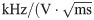
Linear rate response functions and quantities for the cascade models.Linear rate response functions of EIF neurons subject to white noise input for modulations of the input mean around μ with constant σ: Rμ(t; μ, σ) in kHz/V (A, gray) and for modulations of the input standard deviation around σ with constant μ: Rσ(t; μ, σ) in kHz/(V·ms) (B, gray). These functions are calculated in the Fourier domain for a range of modulation frequencies [R^μ(f;μ,σ) in 1/V and R^σ(f;μ,σ) in 1/(V·ms)] (insets, gray; absolute values are shown), and fit using an exponential function exploiting asymptotic results for R^μ (A, red dashed), as well as considering a range of frequencies (A and B, red solid). In addition, R^μ is fit using a damped oscillator function (A, violet). The details of the fitting procedures are described in the text. C: quantities (τμ, τσ, τ and ω) from the linear filter approximations (cf. A, B), required for the LNexp and LNdos model variants (Eqs (85), (87) and (89)), as a function of μ and σ.